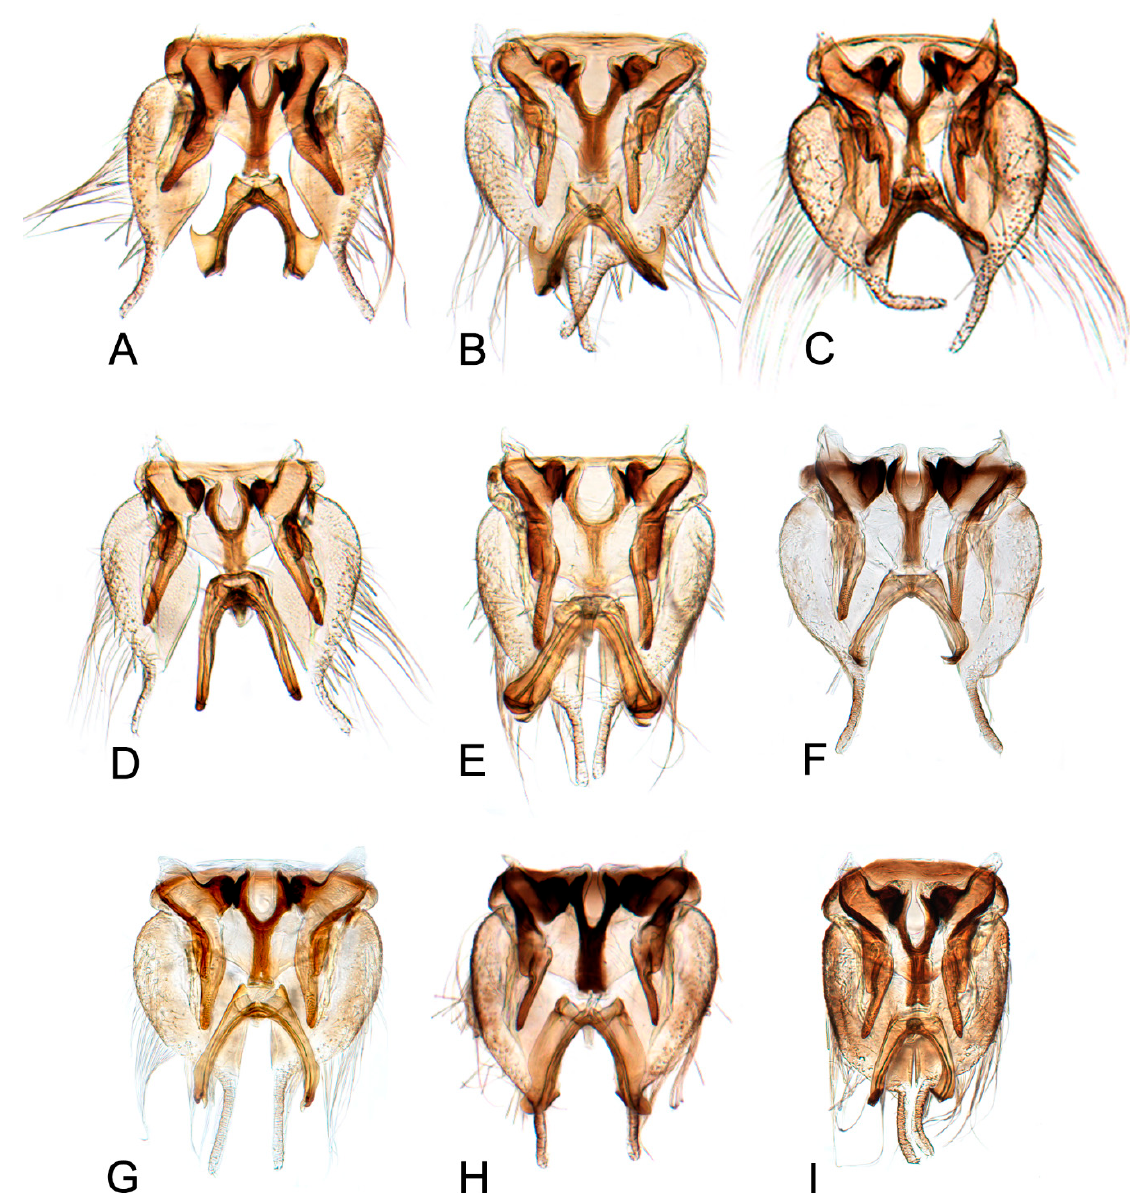
Figure 13. Subgenital plate, valve, style, connective, and aedeagus, dorsal view. ( A ) H. viraktamathiellus ; ( B ) H. triangulus ; ( C ) H. concavus ; ( D ) H. dietrichi ; ( E ) H. bucephalus ; ( F ) H. fletcheri ; ( G ) H. dichotomous ; ( H ) H. sellatus ; and ( I ) H. rectus .